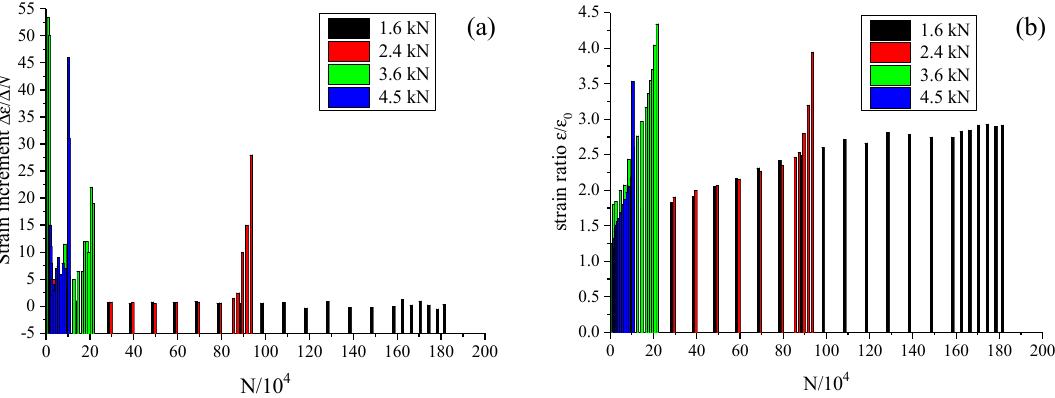
Figure 12. Strain evolutionary characteristics under di ff erent dynamic stress levels: ( a ) strain increment; ( b ) strain ratio.